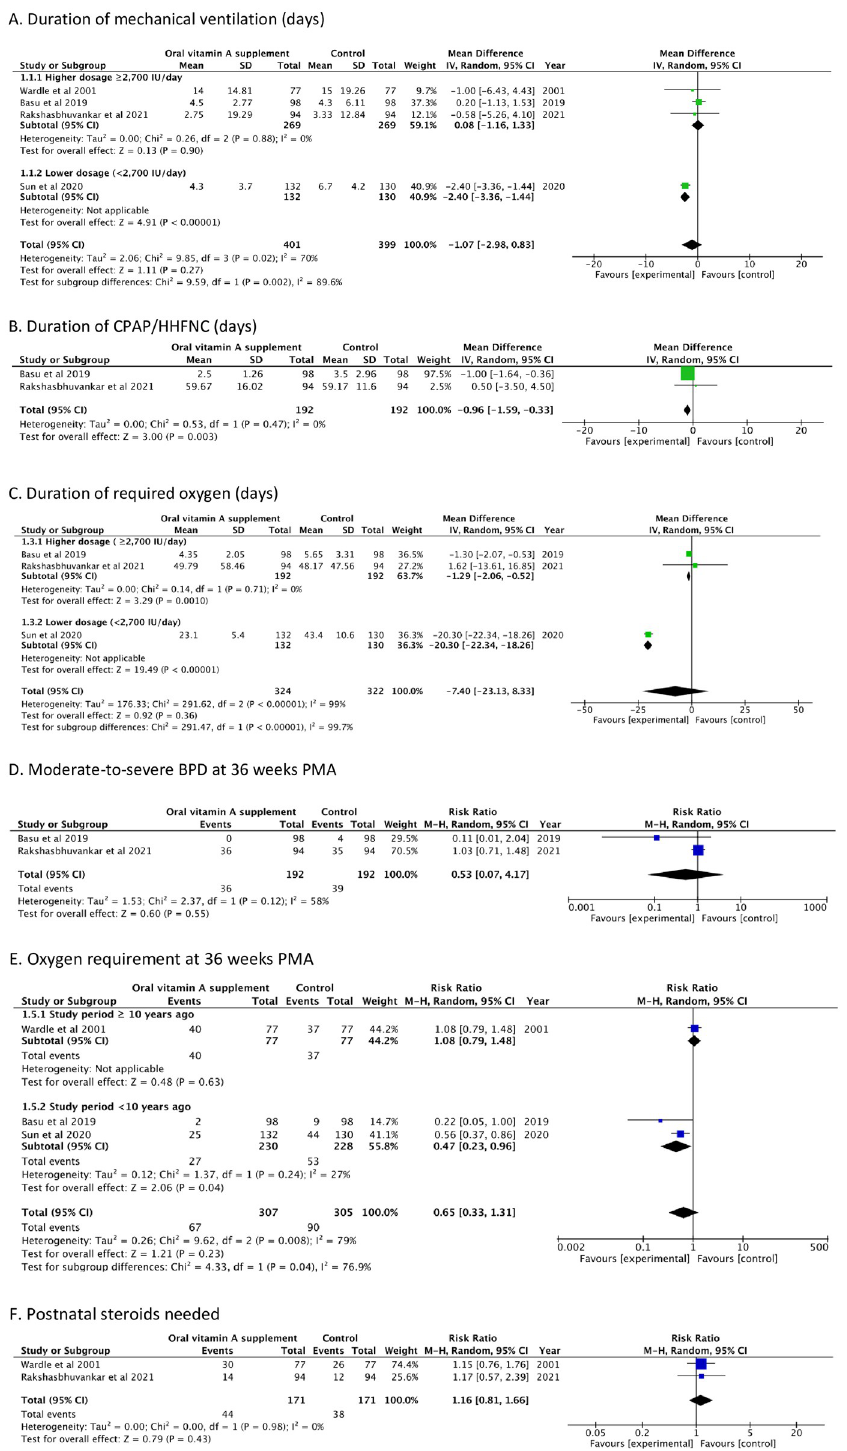
Fig 2. Forest plots of the effects of oral vitamin A supplementation in preterm infants. (A) Duration of mechanical ventilation (days); (B) Duration of CPAP/HHFNC (days); (C) Duration of oxygen requirement (days); (D) Moderate- to-severe BPD at 36 weeks PMA; (E) Oxygen requirement at 36 weeks PMA; (F) Postnatal steroids needed.